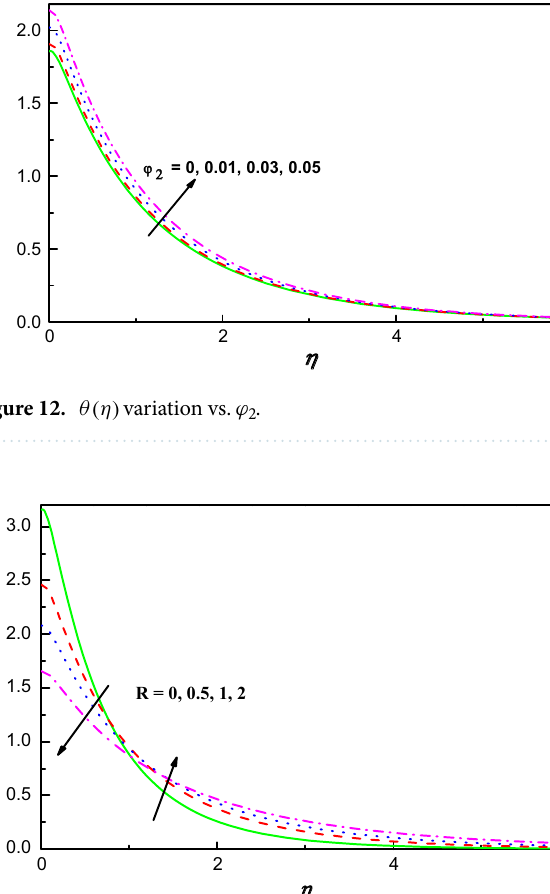
Figure 13. θ(η) variation vs. R .